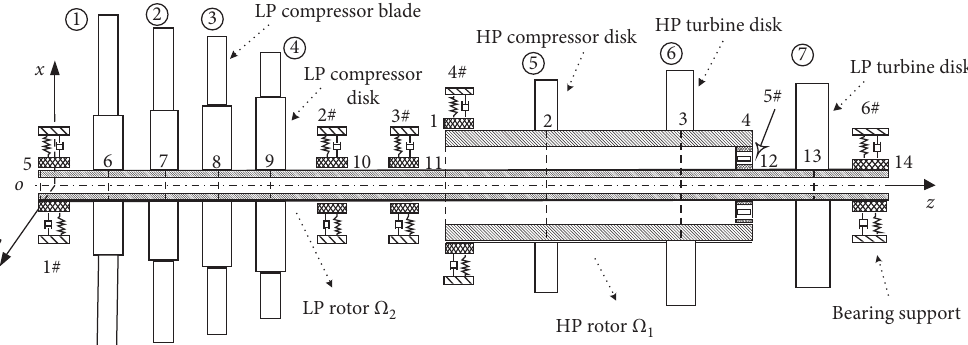
Figure 3: Sketch of a blade-dual-rotor-supporting system.